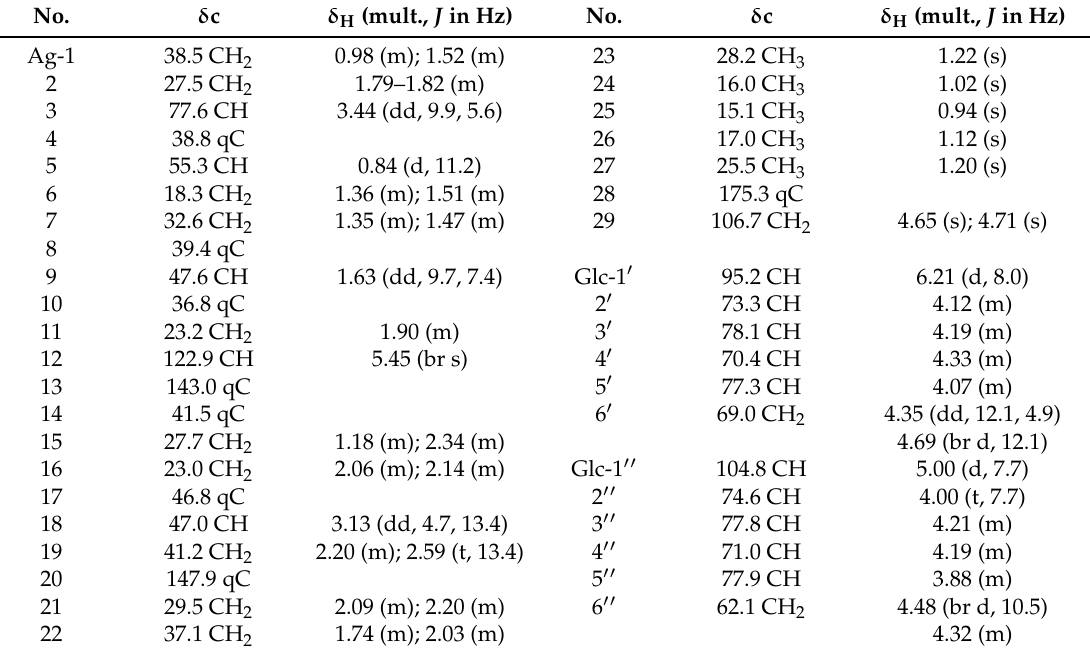
Table 1. NMR spectroscopic data for compound 1 in pyridine- d 5